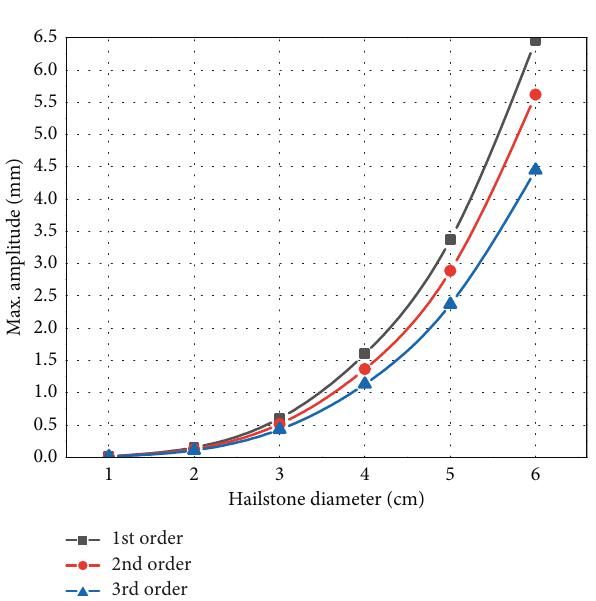
Figure 4: First three-order max. amplitude under impact of hailstone with different diameters when arch-to-span ratio is 1/10 and pretension level is